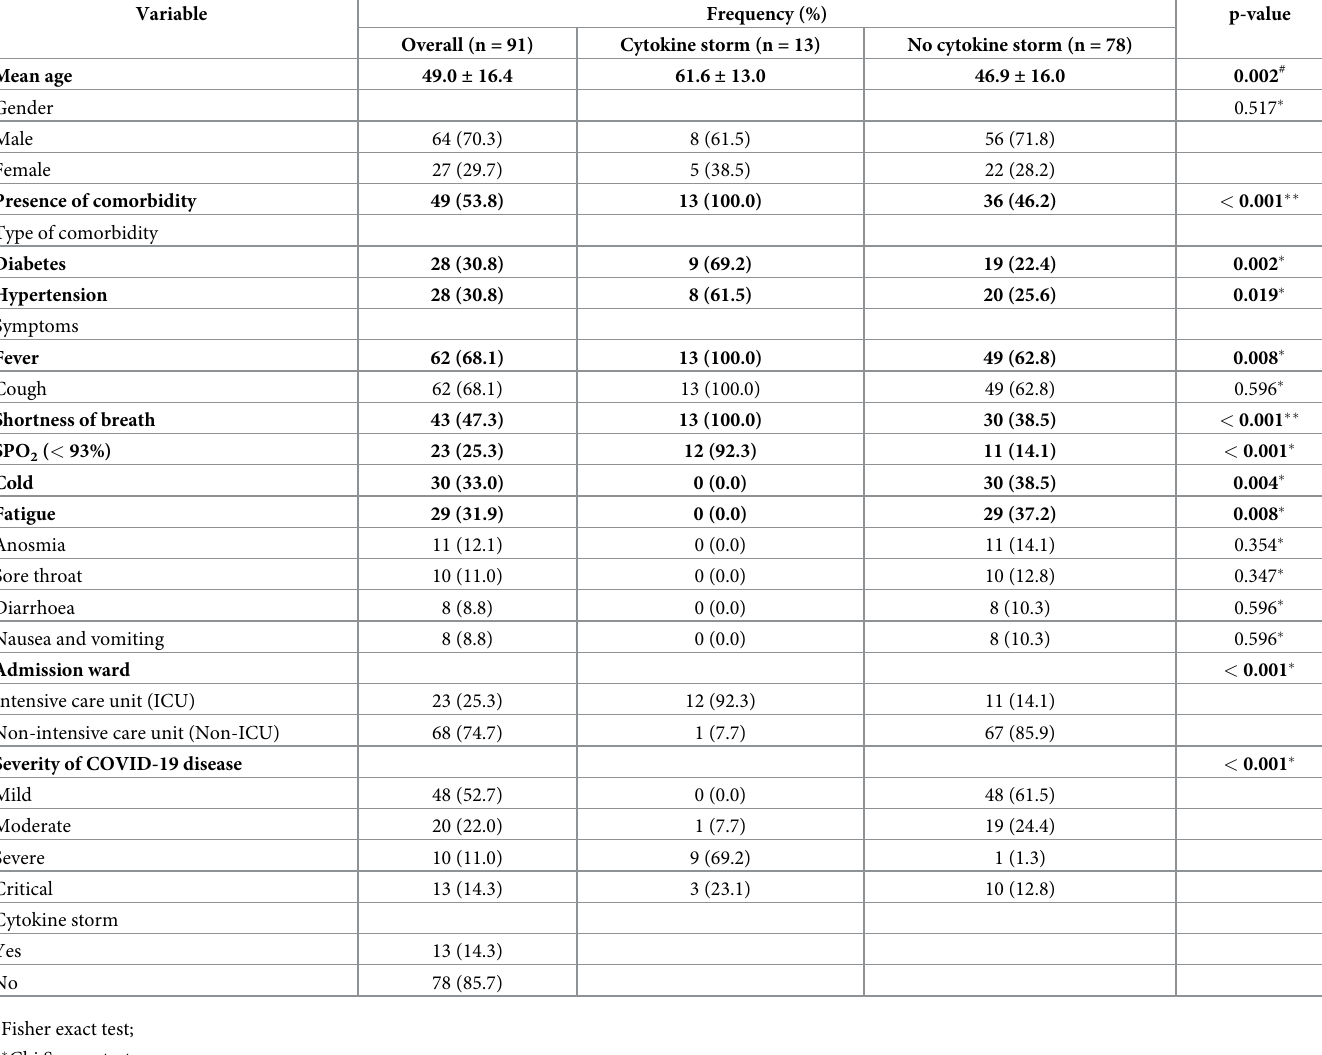
Table 1. Correlation between cytokine storm, sociodemographic and clinical